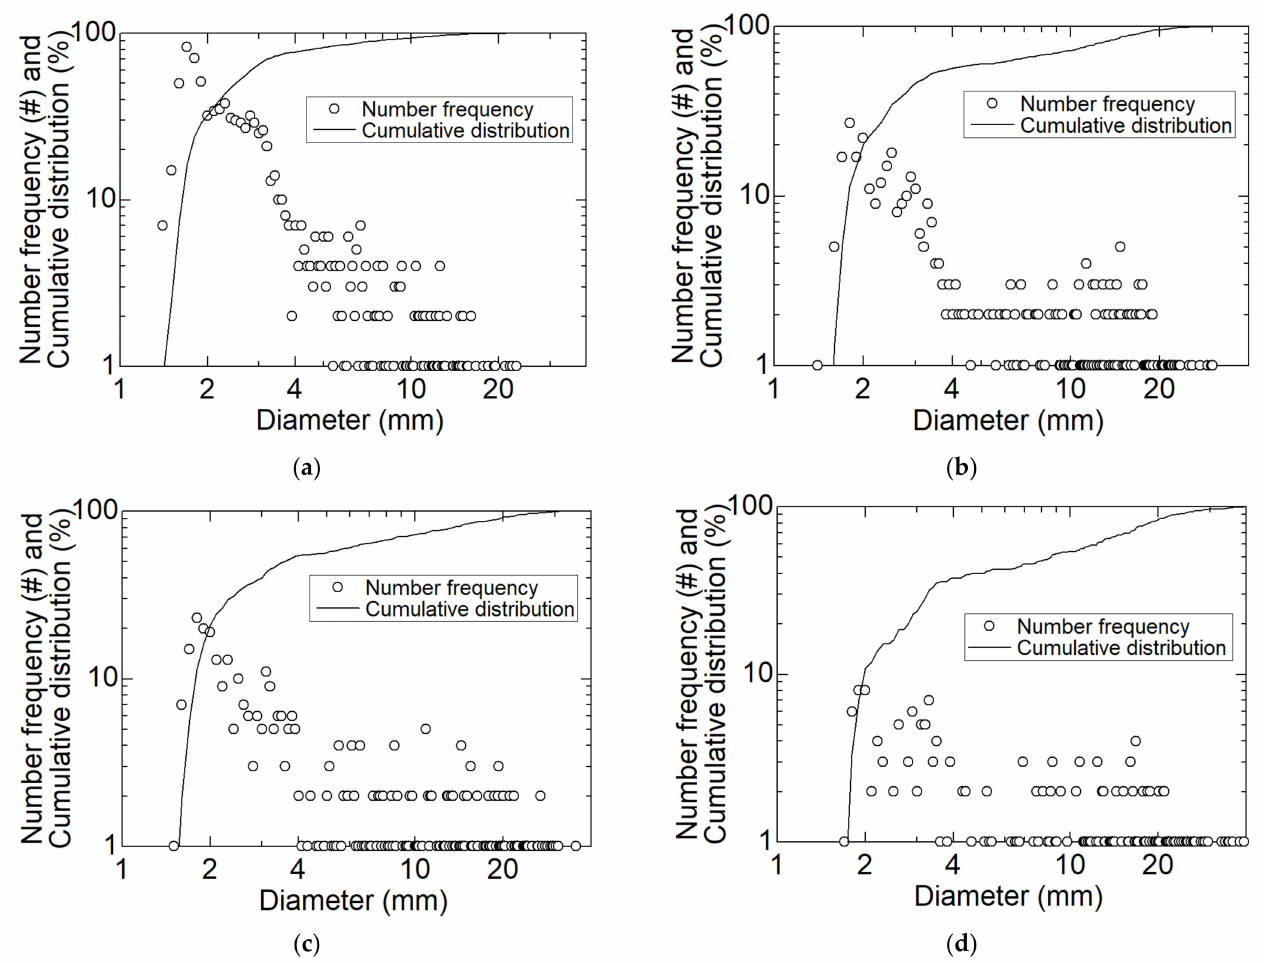
Figure 7. Particle size distribution with cumulative distribution: ( a ) in visualization region (A); ( b ) in visualization region (B); ( c ) in visualization region (C); ( d ) in visualization region (D).